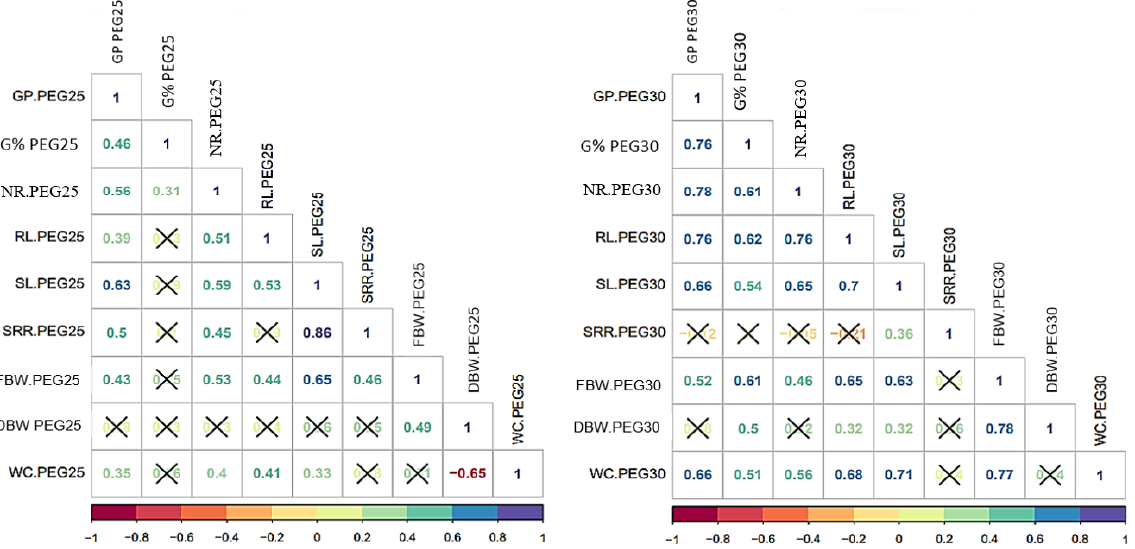
Figure 2. Correlations between germination and seedling growth parameters under PEG25% (left) and PEG30% (right) among 41 spring wheat genotypes. Germination pace (GP); Germination percentage (G%); Number of root (NR); Root length (RL); Shoot length (SL); Shoot-root length ratio (SRR); Fresh biomass weight (FBW); Dry biomass weight (DBW); Water content (WC); where (X) stands for non-significant correlations.